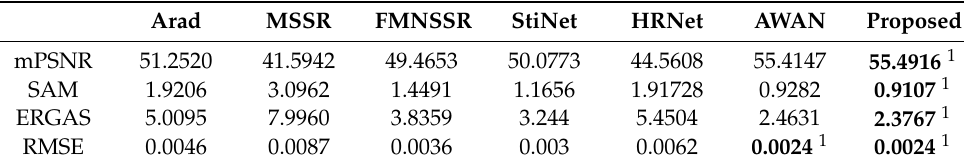
Table 3. Quality assessment comparison on the University of Houston data